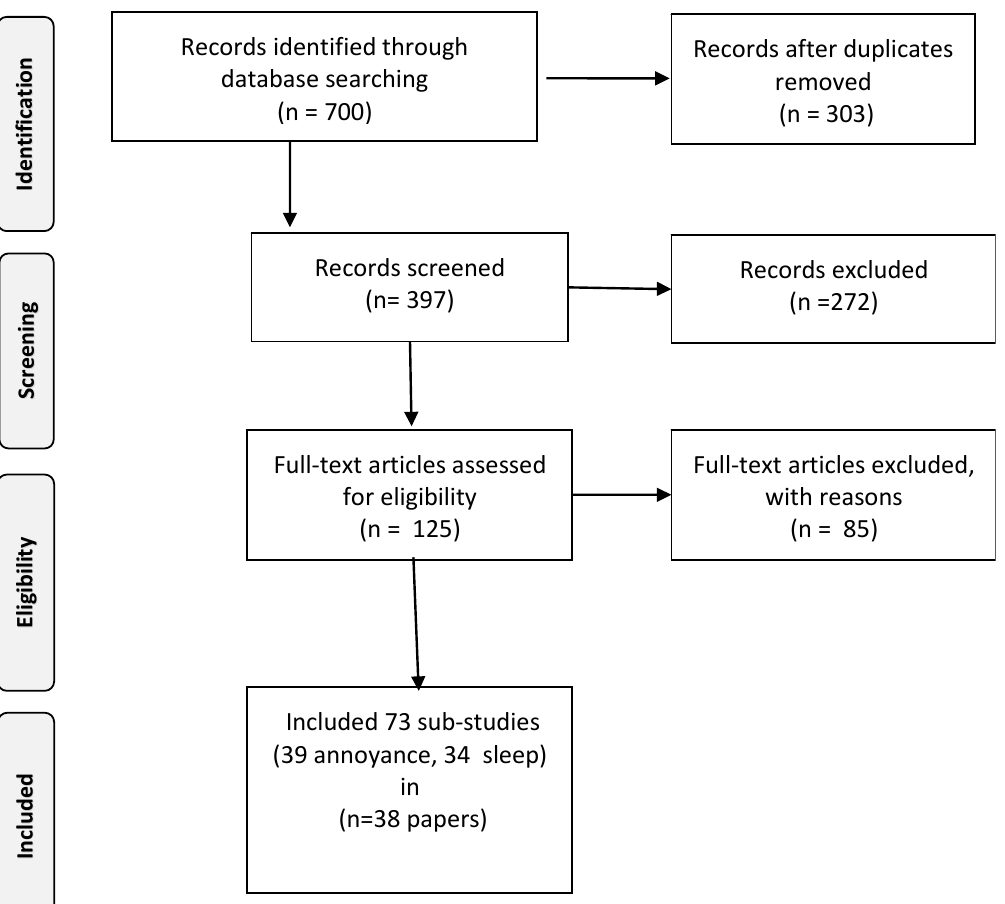
Figure 1. Flowchart outlining the study selection process for annoyance and sleep